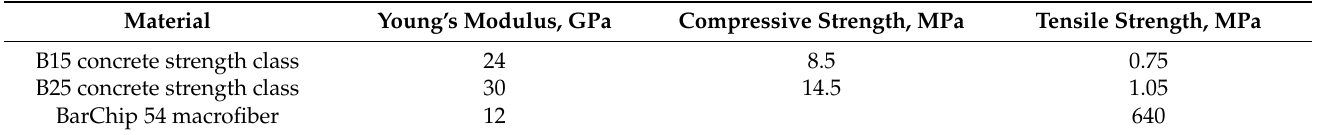
Table 1. Basic mechanical properties of the studied